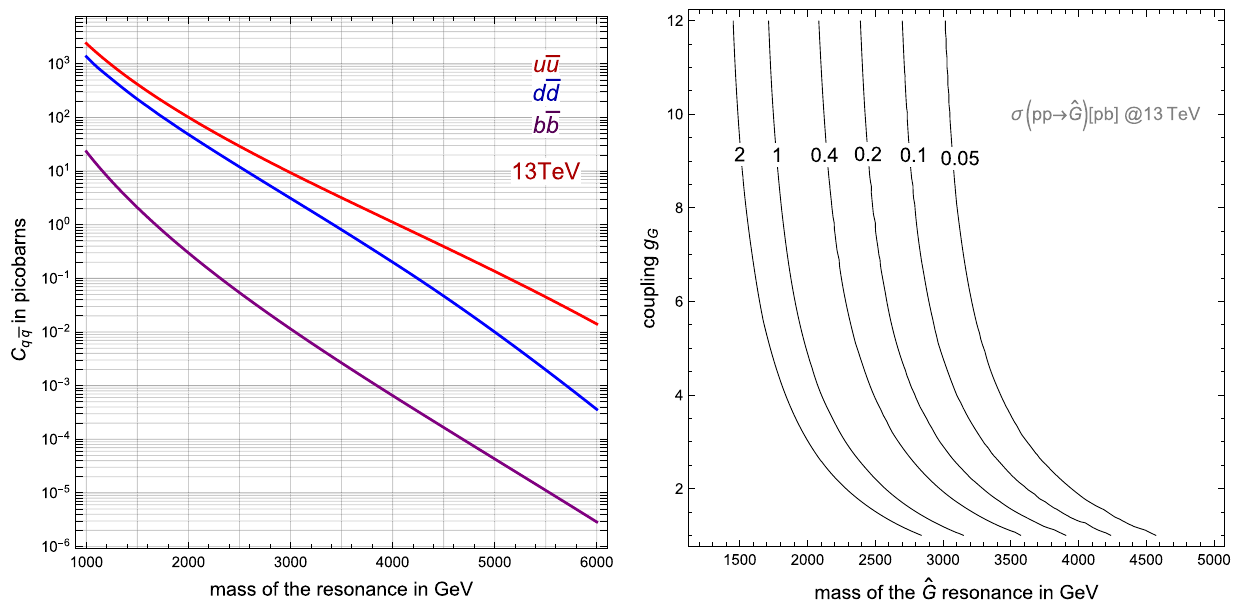
Fig. 2 Left: C q ¯ q for different initial states at 13 TeV as function of the mass of the resonance. Right: production cross section of the ˆ G res- , which controlsthe b ¯ b production channel onance. The coupling ˆ g G s 2 q 3